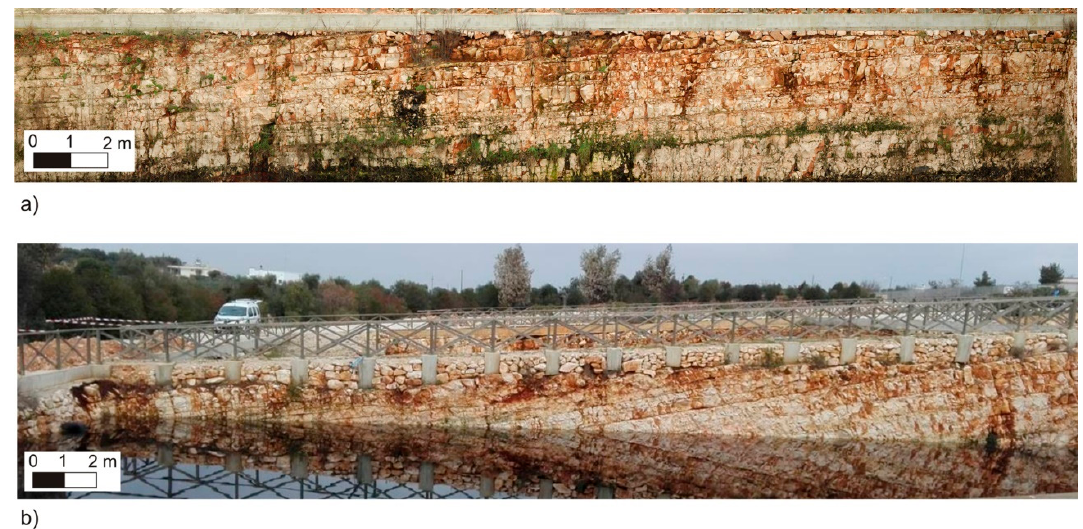
Figure 2. Stratigraphic layout of the epikarst zone. ( a ) East side; ( b ) north side of the trench.